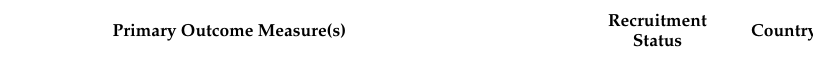
Table 1. Ongoing clinical trials registered on ClinicalTrials.gov until 28 September 2022, comparing safety and efficacy of autologous adipose tissue with platelet-rich plasma for treatment of knee